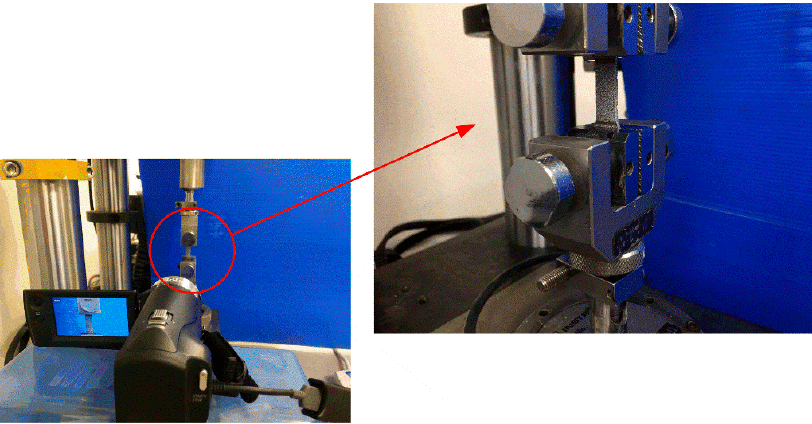
Figure 2. Quasi-static tensile test based on universal Instron testing machine.